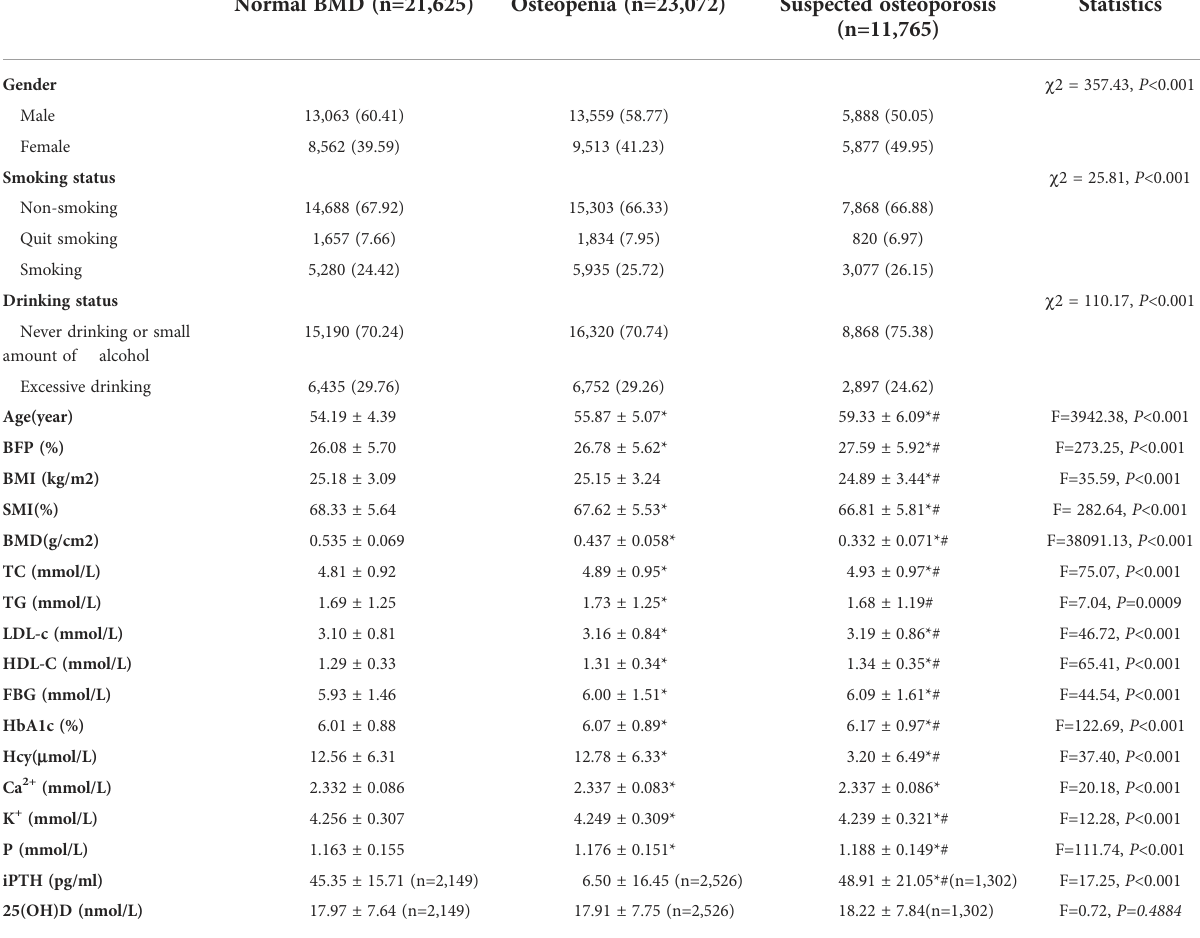
TABLE 1 Comparison of three groups of basic data and clinical indexes